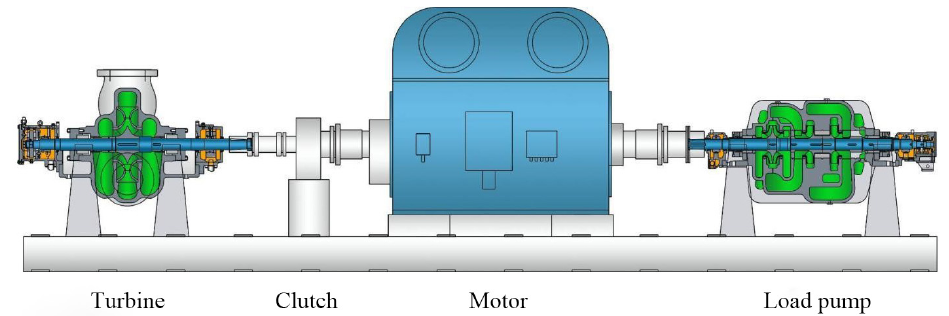
Figure 1. Turbine in desulfurization tower.